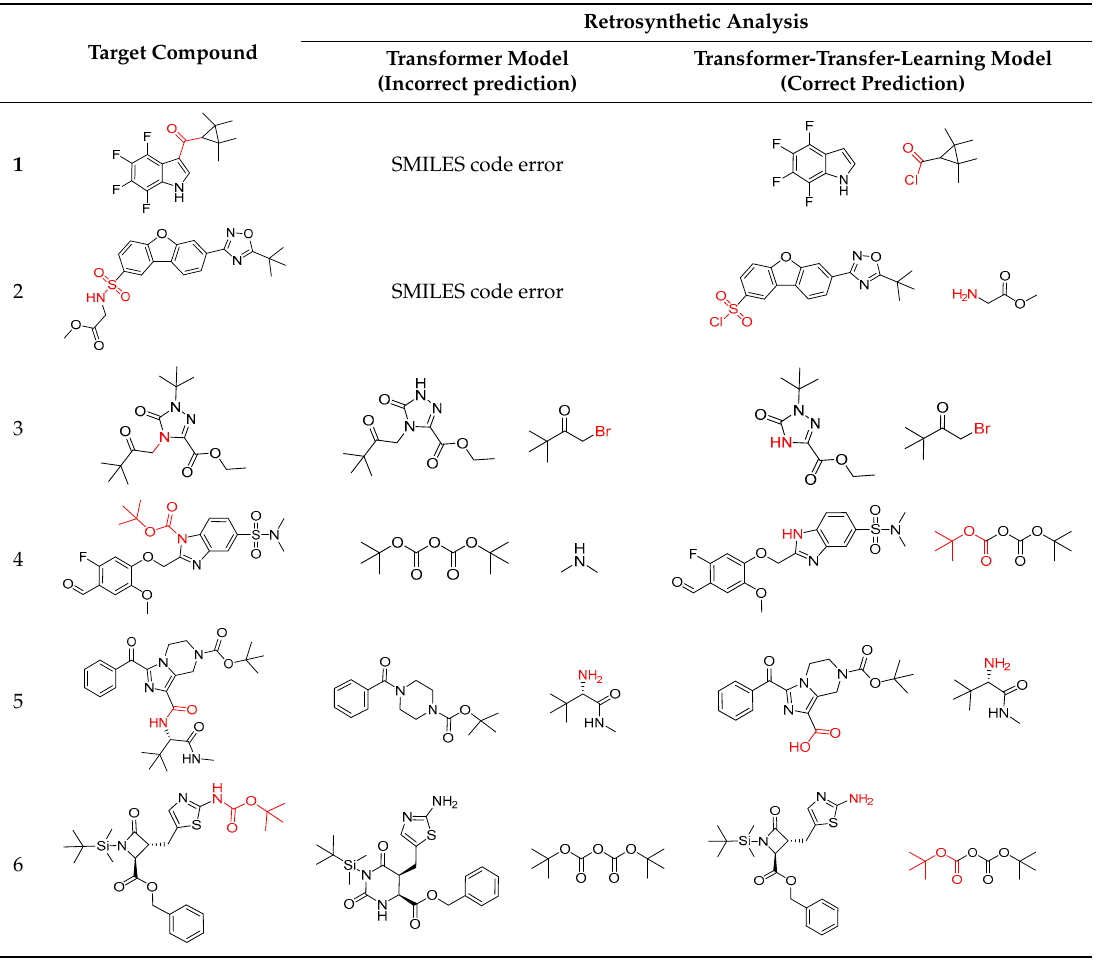
Table 8. Comparisons and representative examples (selected from the test set) of the Transformer and Transformer-transfer-learning models in retrosynthetic prediction with tert-butyl moieties.